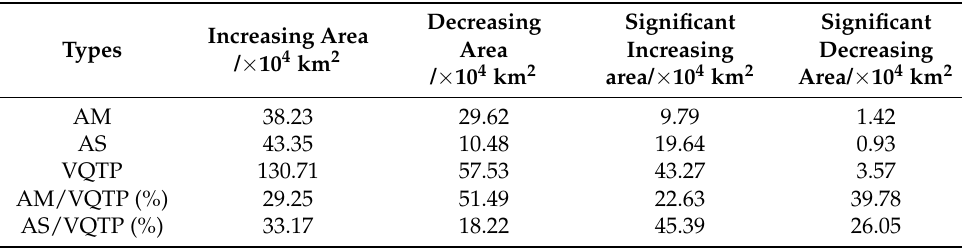
Table 3. Statistics for the growing season NDVI variation trends for the AM, AS and VQTP in the QTP from 2000 to